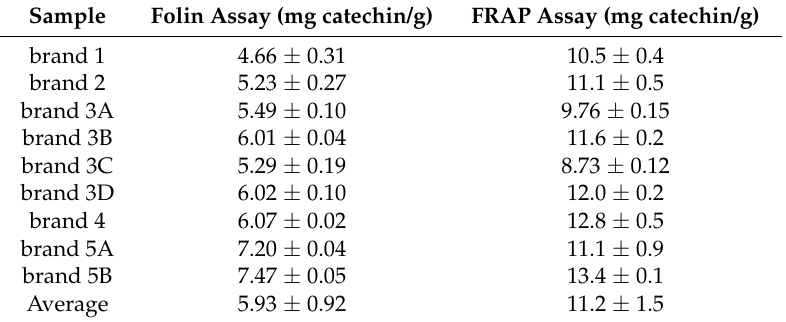
Table 1. Total phenolic content and antioxidant capacity of raw kernel samples found by chemical basic hydrolysis. Quantities are reported as mg catechin equivalent per gram. Results are mean ± standard deviation, n =